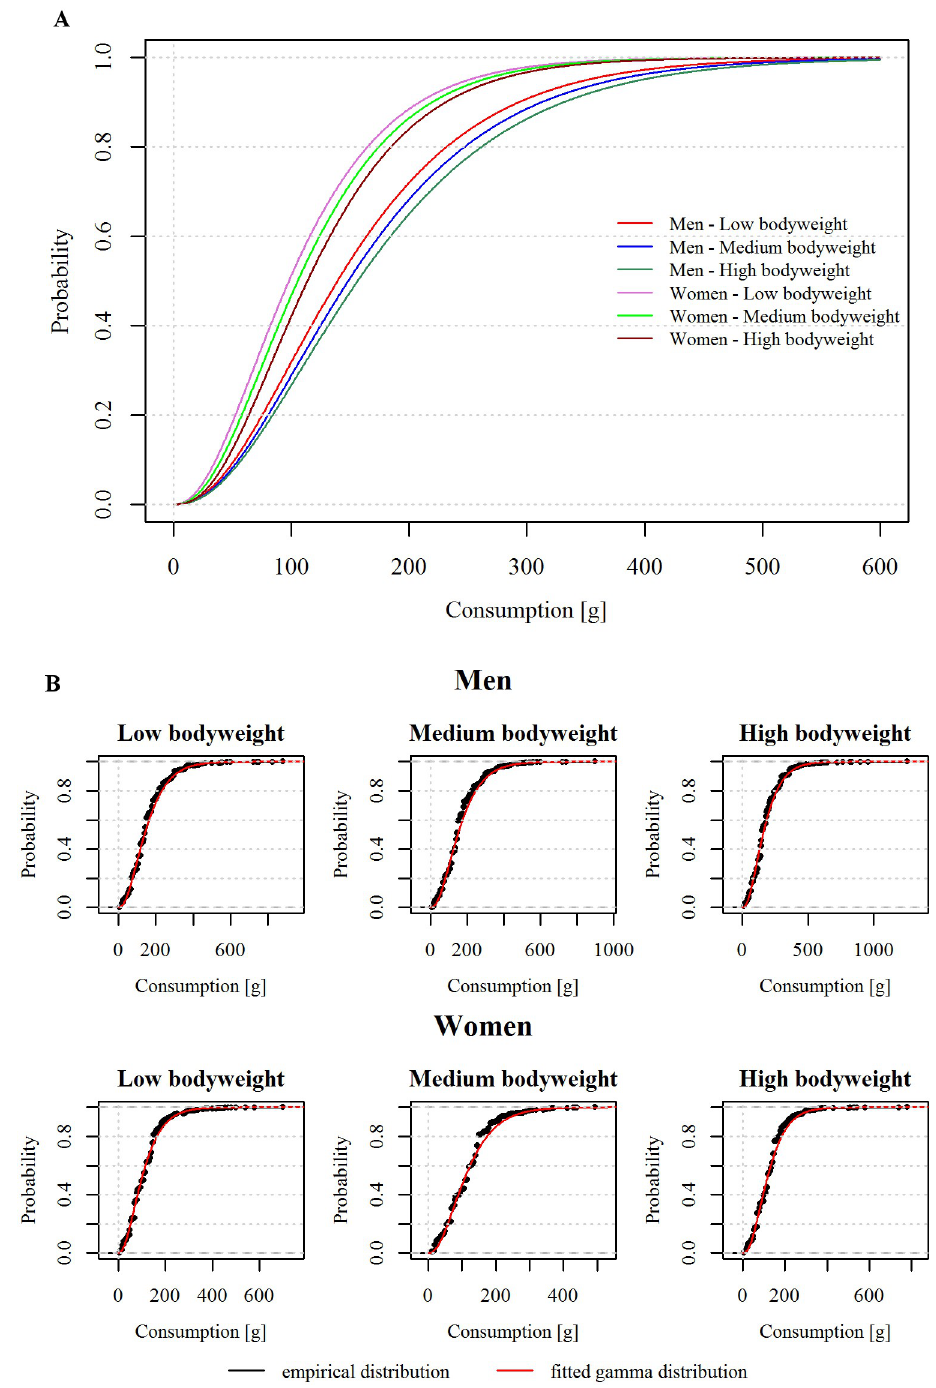
Fig 2. Cumulative distribution functions of meat consumption in g/meal for each sex and weight class. A: The theoretical cumulative distribution functions of the fitted gamma distributions. B: The empirical and theoretical cumulative distribution functions of meat consumption for each sex and weight class. The red line in each graph represents the gamma distribution fitted to the meat consumptions. The black lines depict the empirical distributions and the black marks represent the observed consumed amounts of